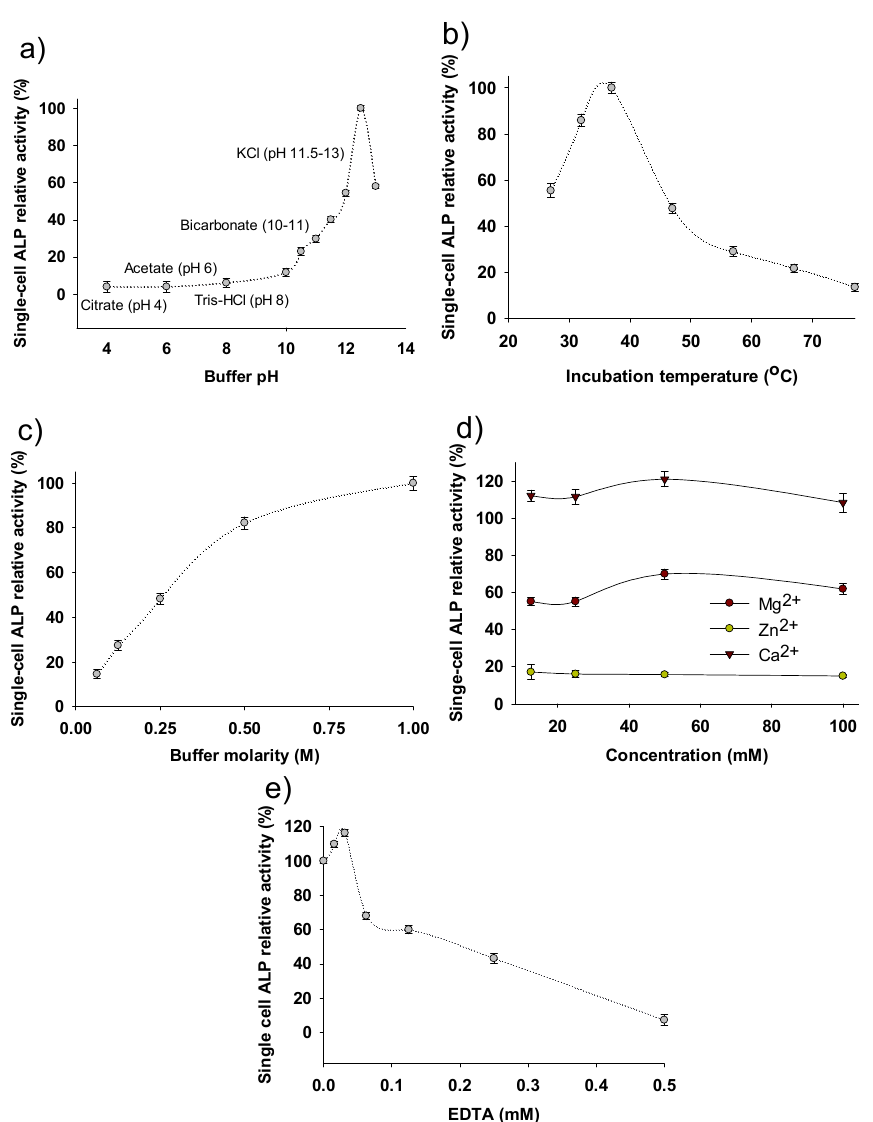
Figure 2. Effect of selected parameters on the single-cell alkaline phosphatase activity assay: ( a ) effect of the pH of the buffer (1 M KCl + NaOH, pH 12.5, T = 37 °C), ( b ) temperature of incubation (1 M KCl, pH 12.5), ( c ) molarity of the buffer (pH 12.5, T = 37 °C), ( d ) of the treatment of biomass with metal ions (Mg 2+ , Zn 2+ , and Ca 2+ ); (1 M KCl, pH 12.5, T = 37 °C) and ( e ) of the treatment of biomass with EDTA (1 M KCl, pH 12.5, T = 37 °C). Data shown are the mean ± SD of n = 3.